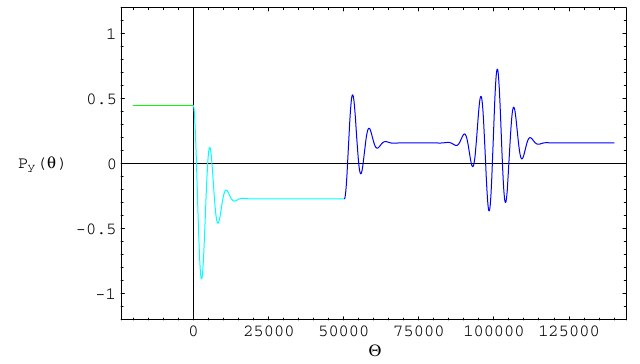
FIG. 6. (Color) Expected polarization in an echo experiment.